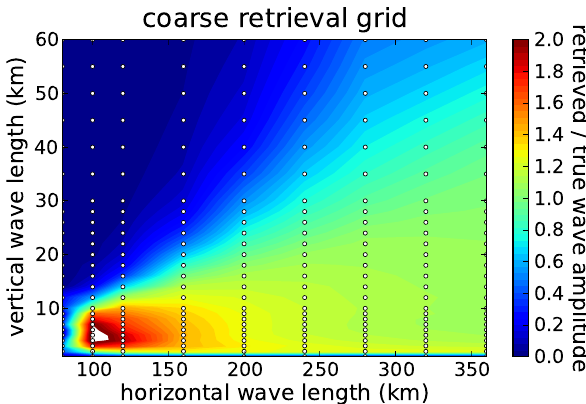
Fig. 10. This shows the observational filter derived with a sampling grid of 50km horizontal distance instead of the usually employed 12.5km. Please note the different colour scale compared to Fig.